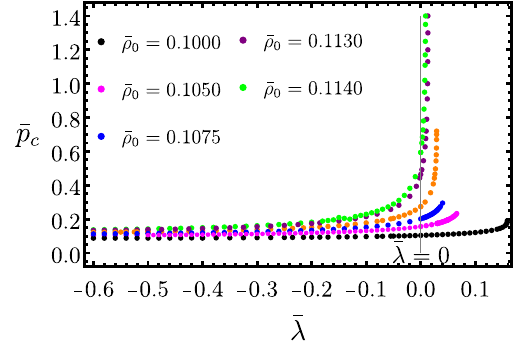
Fig. 3 Central pressure as a function of ¯ λ for different values of ¯ ρ 0